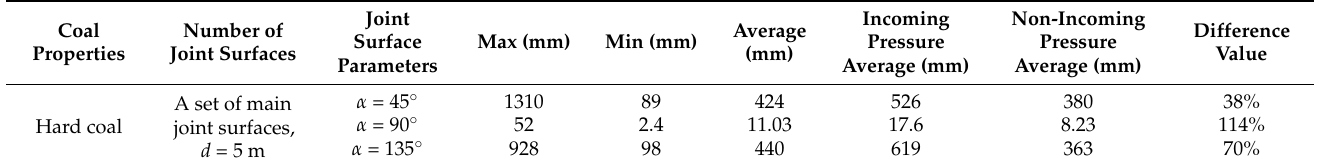
Table 8. Coal wall Y-displacement at different joint inclination